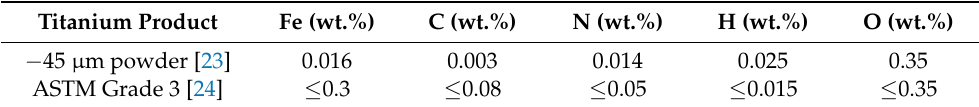
Table 1. Impurity content of the supplied − 45 µ m Ti-HDH powder and ASTM grade 3 titanium. HDH: hydride-dehydride. ASTM: American Society for Testing and Materials.